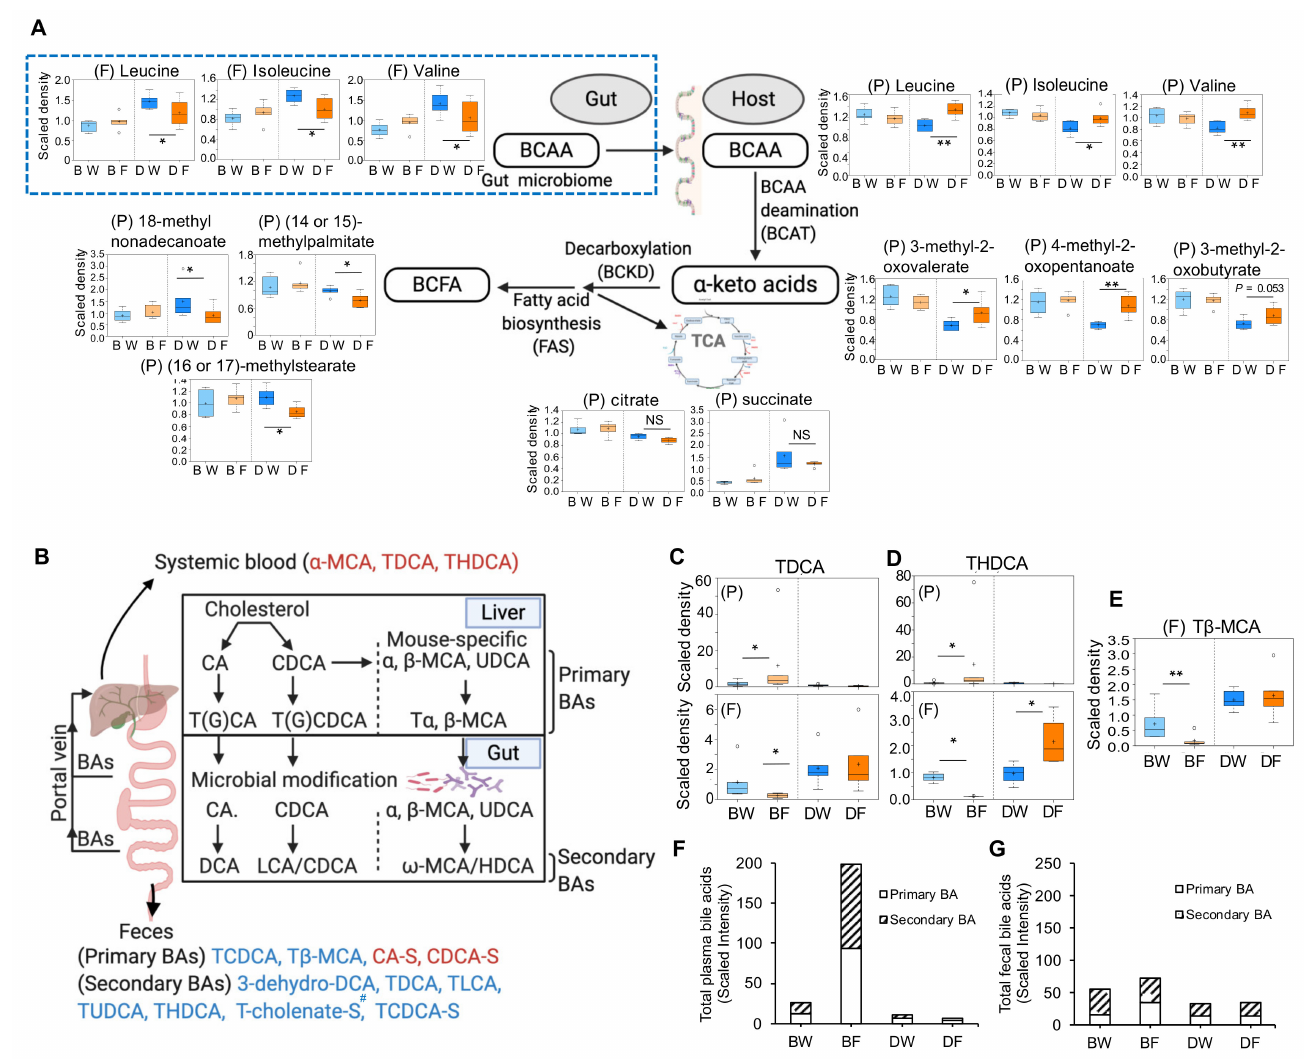
Figure 5. Strain-specific metabolic pathways altered by fructose consumption between DBA and B6 mice. ( A ) Alterations in BCAA and BCFA metabolism pathways in DBA mice. Box plots show the levels of relevant plasma or fecal metabolites in water and fructose groups of DBA mice. BCAA, branched chain amino acid; BCFA, branched chain fatty acid; BCAT, branched chain aminotransferase; BCKD, branched-chain α -ketoacid dehydrogenase complex; FAS, fatty acid synthase, TCA, tricarboxylic acid cycle. ( B ) Schematic representation of enterohepatic circulation of bile acids and differentially altered bile acids in the plasma or feces of B6 mice. Blue or red colored bile acids are the decreased or increased bile acids by fructose consumption in B6 mice, respectively. G, glycine-conjugated species; T, taurine-conjugated species; S, sulfated species; CA, cholic acid; CDCA, chenodeoxycholic acid; MCA, muricholic acids; UDCA, ursodeoxycholic acid; DCA, deoxy cholic acid; LCA, lithocholic acid; HDCA, hyodeoxycholic acid. ( C – E ) Box plots of select secondary ( C , D ) and primary ( E ) bile acids in plasma (upper panels of C , D ) and feces (lower panels of C – E ) of B6 and DBA treated by regular water or fructose water. Total bile acid in plasma ( F ) and feces ( G ). n = 5–6/group. Statistical significance was determined by ANOVA contrast (* p < 0.05, ** p < 0.01). NS indicates non-significant difference. BW, B6 water group; BF, B6 fructose group; DW, DBA water group; DF, DBA fructose group; P, plasma; F, feces. Symbol (#) next to metabolite indicates the